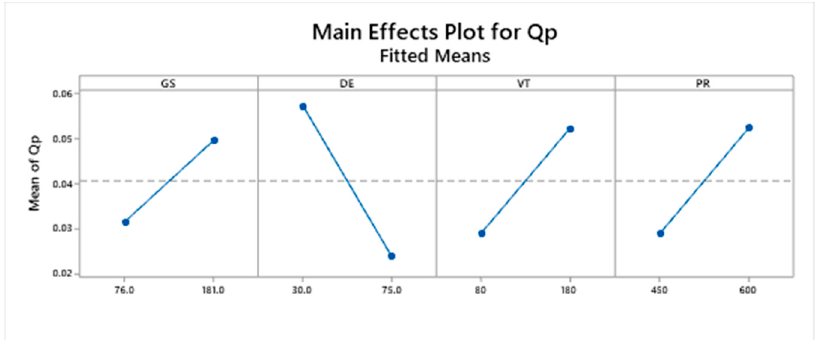
Figure 9. Main effects plot for tool wear Qp.